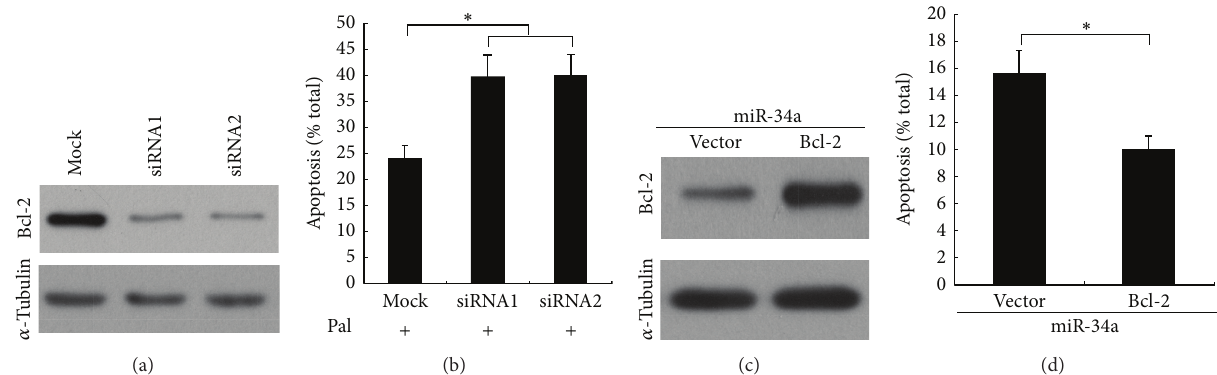
Figure 4: Bcl-2 is functionally related to the effect of miR-34a in response to palmitate. (a) Min6 cells transfected with specific siRNAs against mouseBcl-2. WB assay were performed to confirm theeffect of siRNAs. 𝛼 -Tubulin was used as loading control. (b)Min6 cells were transfected with specific siRNAs against mouse Bcl-2. The cells were cultured for 48h in DMEM containing 1mM palmitate. The number of apoptotic cells was evaluated by scoring cells displaying pycnotic nucleus and/or fragmented nucleus visualized with Hoechst 33342. (c) Reexpression of Bcl-2 with the expression plasmid pcDNA3-M-Bcl-2 in the miR-34a-overexpressing Min6 cells. WB assay was performed to confirm the effect of Bcl-2 overexpression. 𝛼 -Tubulin was used as loading control. (d) Reexpression of Bcl-2 partially antagonized the miR-34a-induced cell apoptosis. For (b) and (c), data are means ± SD of triplicate assays in three independent experiments ∗ 𝑃 < 0.05